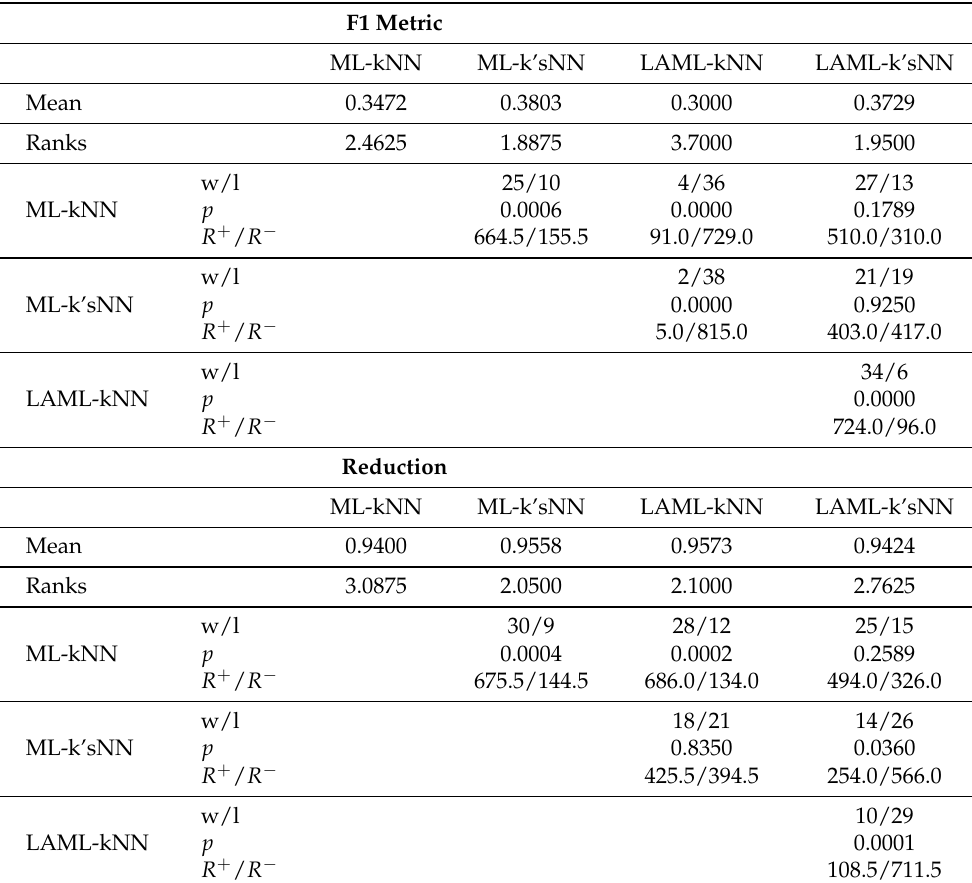
Table 9. Comparison of the different methods’ instance selection